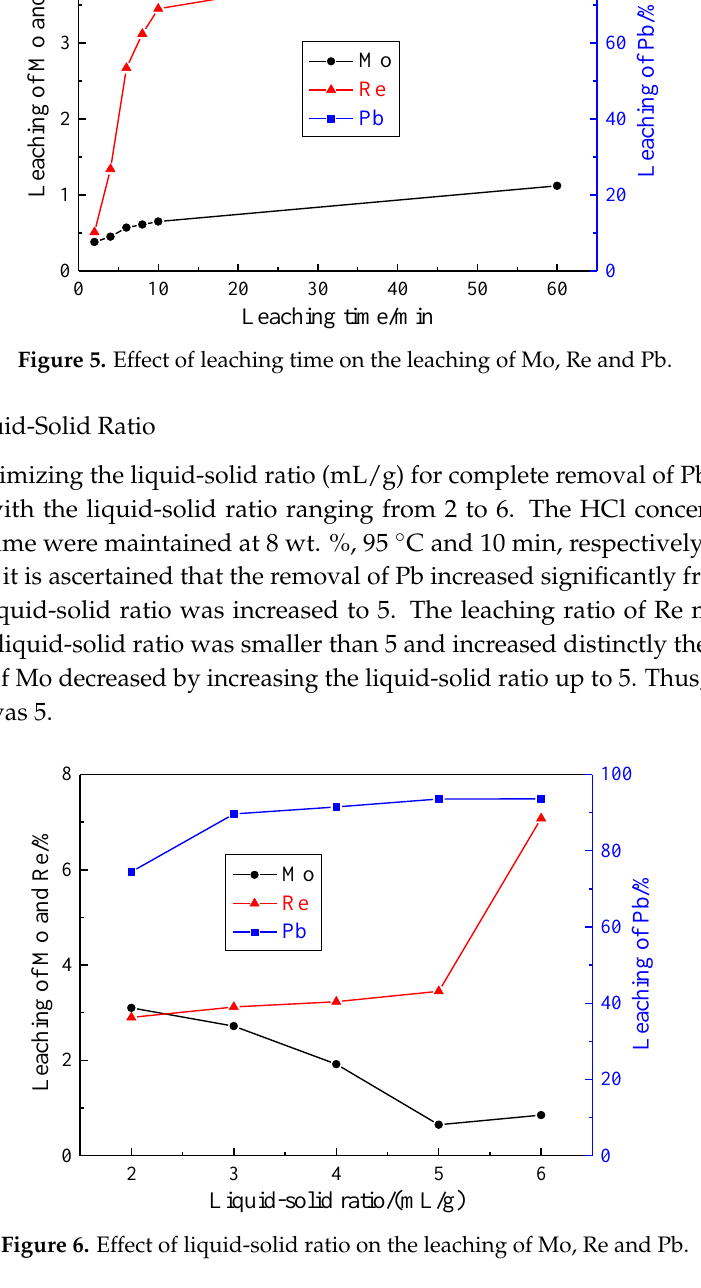
Figure 4. Effect of leaching temperature on the leaching of Mo, Re and Pb.